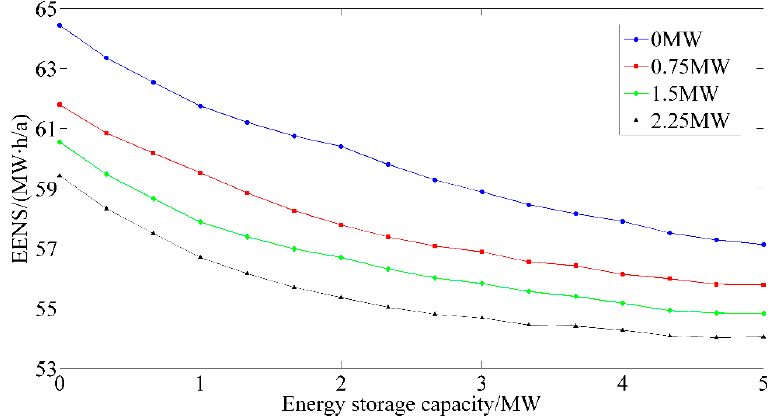
Figure 8. EENS with different storage capacities.